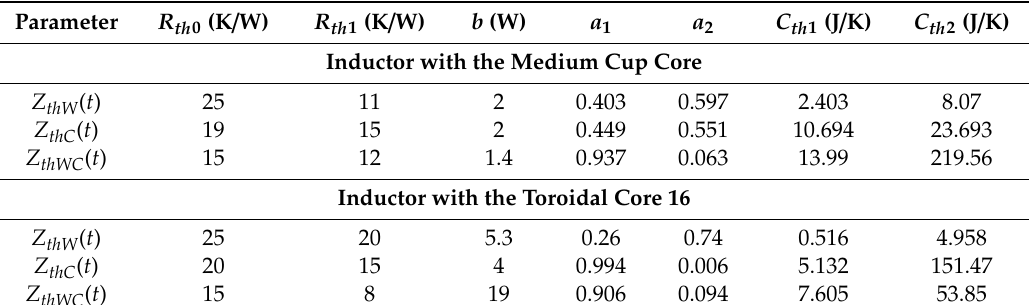
Table 3. Values of parameters of the nonlinear thermal model of inductors with the medium cup core and with the toroidal core.